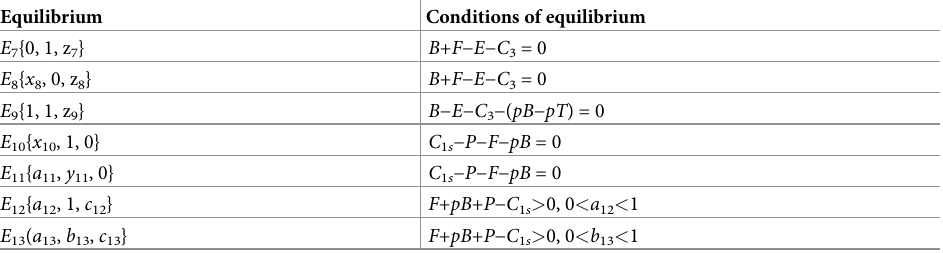
Table 4. Conditional equilibria of the tripartite evolutionary